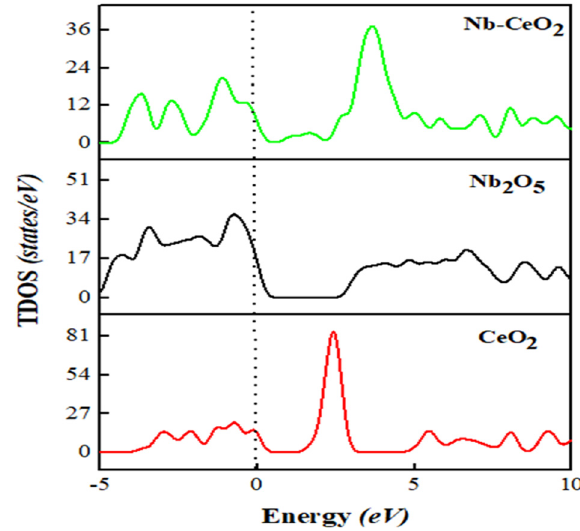
Figure 9: TDOS of the